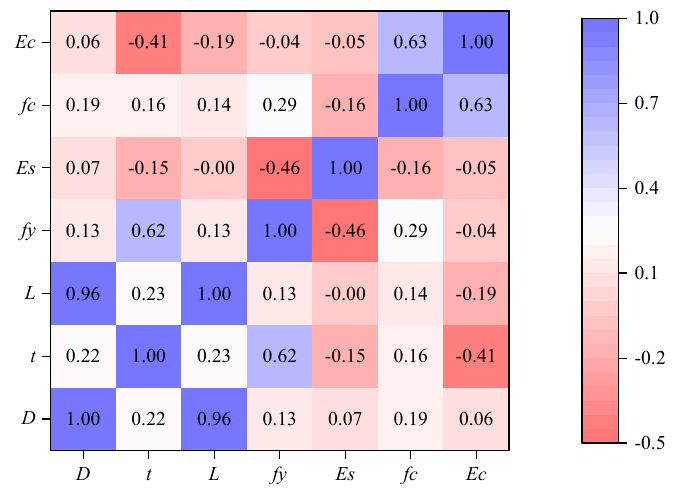
Figure 3. Correlation matrix of seven input variables.